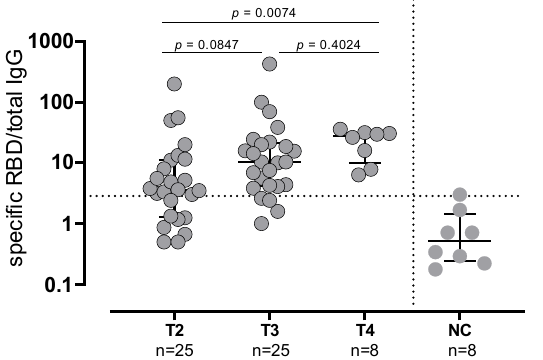
Figure 3. Spike-specific memory B cells secreting IgG antibodies evaluated in 25 subjects at T2 and T3 and in 8 subjects at T4. NC: negative controls.